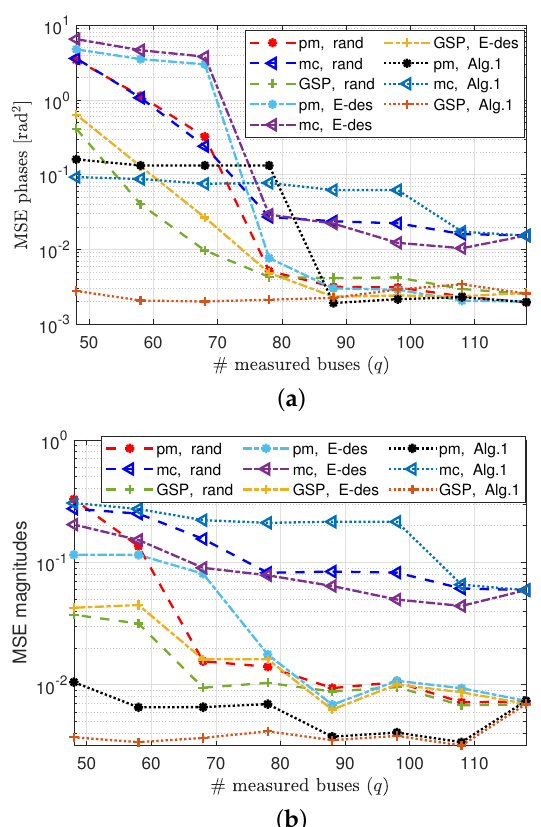
Figure 10. State estimation under the AC − PF model: the phase MSE ( a ) and the magnitude MSE ( b ) of the pm − WLS [11], mc [5], and GSP − WLS (Algorithm 2) estimators for random, E − design [38], and Algorithm 1 bus selection policies versus the number of buses, q .